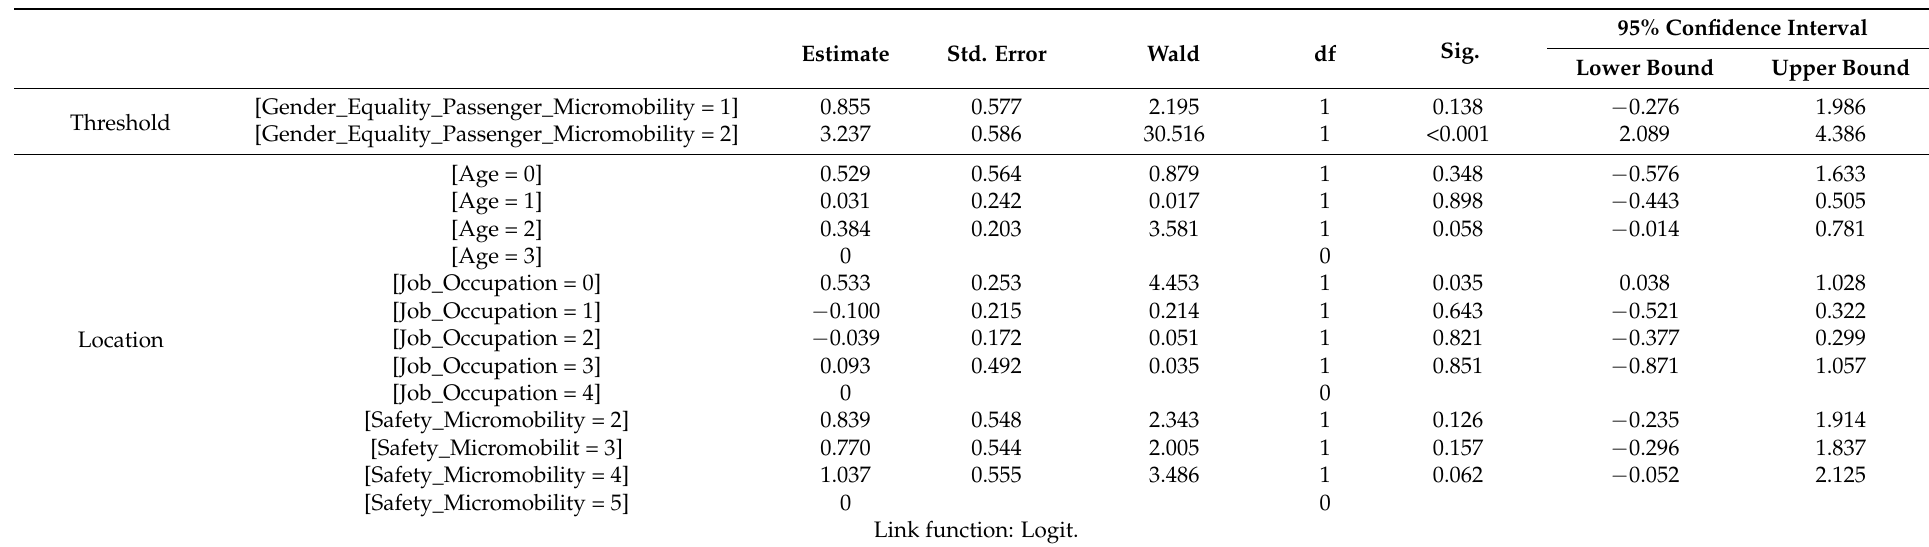
Table 4. Parameter estimates for the Gender Equality